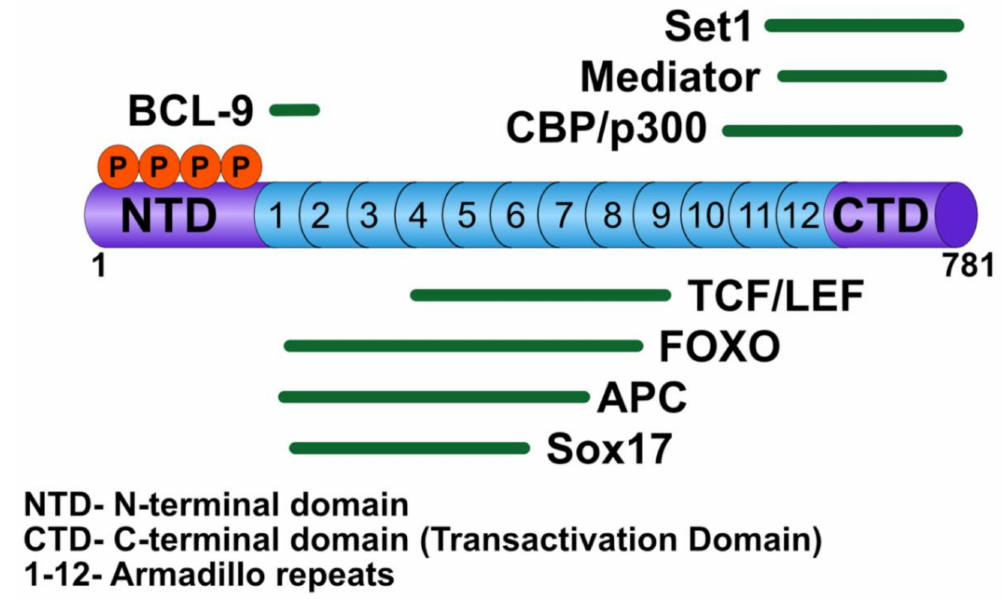
Figure 2. Cartoon of β -catenin and its nuclear interacting